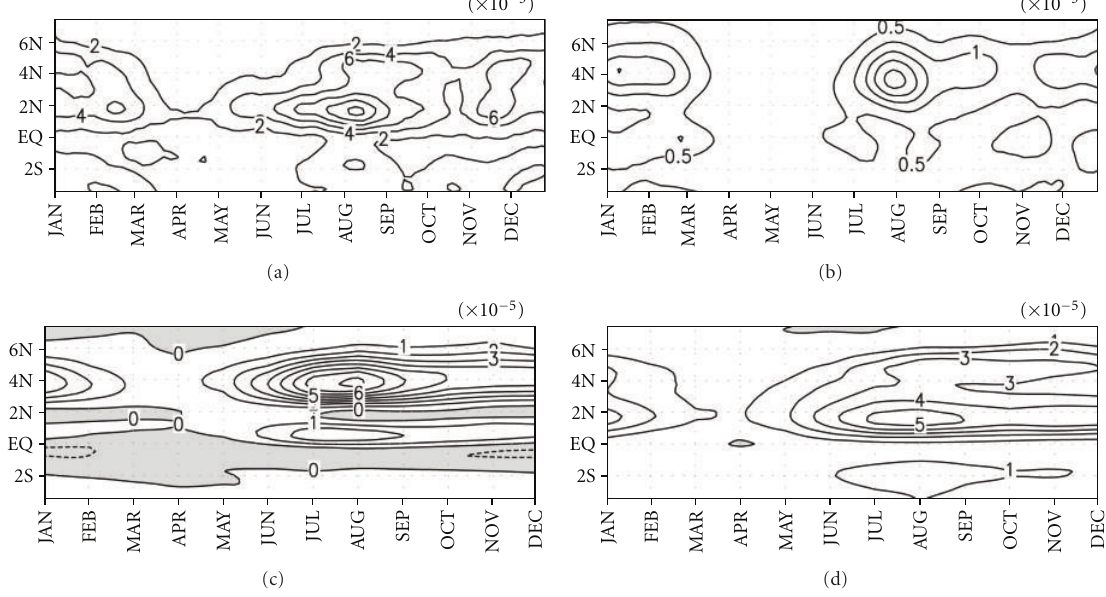
Figure 4: The 50-year climatological mean of the 30-day moving variance of filtered temperature (a) and meridional current (b), and barotropic (c) and baroclinic (d) conversion rates averaged between 160–100 ◦ W, and over the upper 50m. Units are W/m 3 for (c) and (d). Negative values are